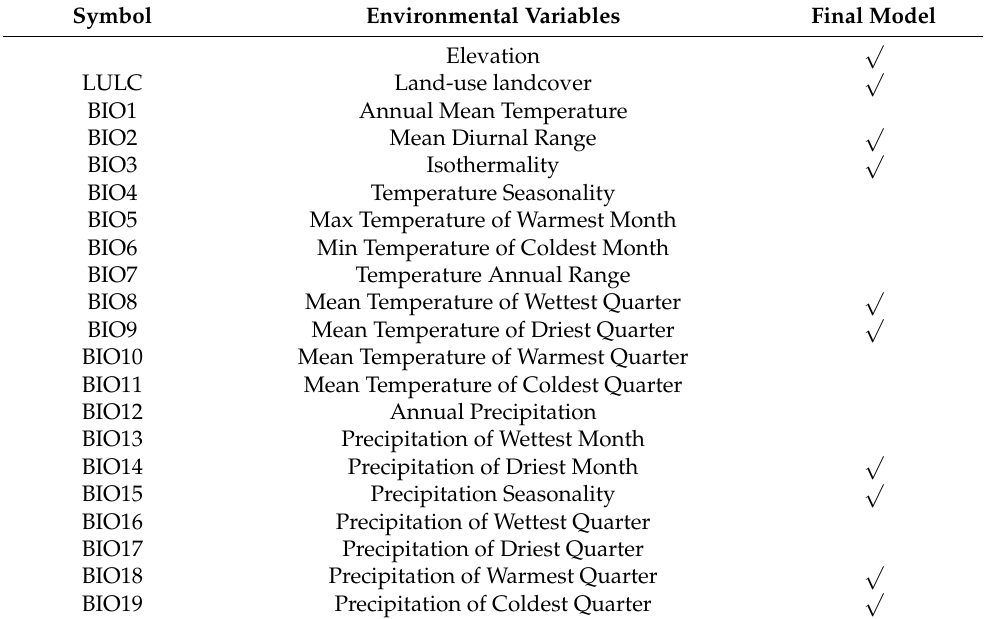
Table 1. Variables included in the final Maxent